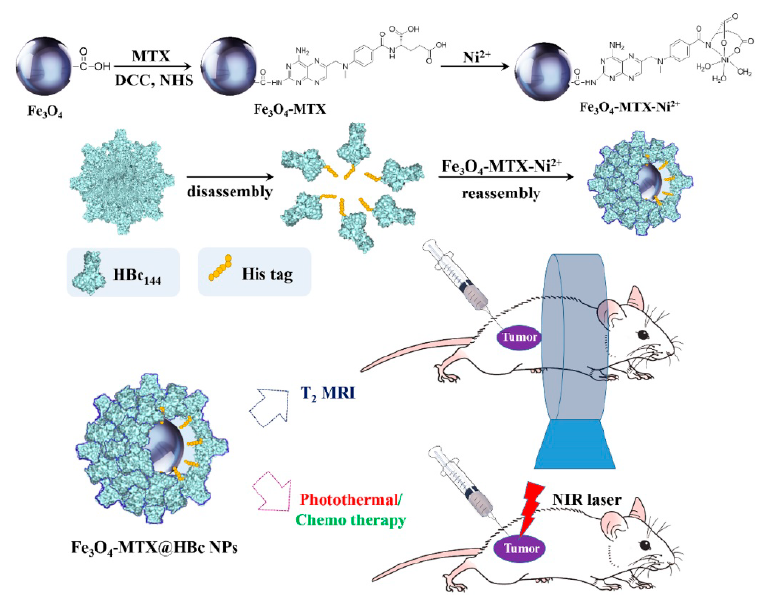
Figure 5. Schematic description of Fe 3 O 4 magnetic nanoparticles conjugated with methotrexate for triple action in imaging (MRI contract agent) and therapeutic (photothermal and chemo therapy).